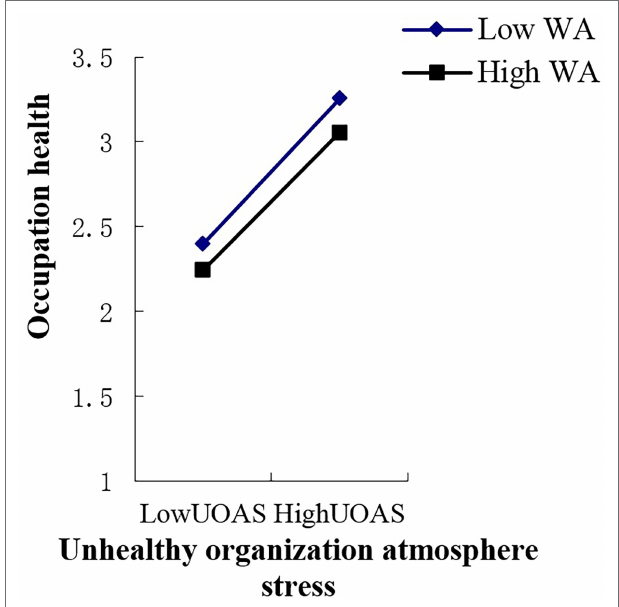
FIGURE 2 | Interactive effects of WA and UOAS on OH. WA, work adaptability; UOAS, unhealthy organization atmosphere stress; OH, occupation